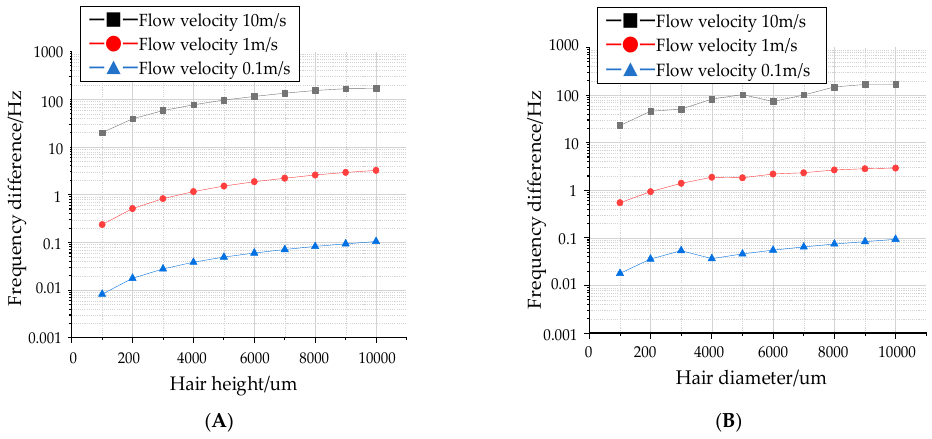
Figure 3. Influence of hair parameters on input and output characteristics. ( A ) Relationship between hair height and output frequency at different flow velocities. ( B ) Relationship between hair diameter and output frequency at different velocities.